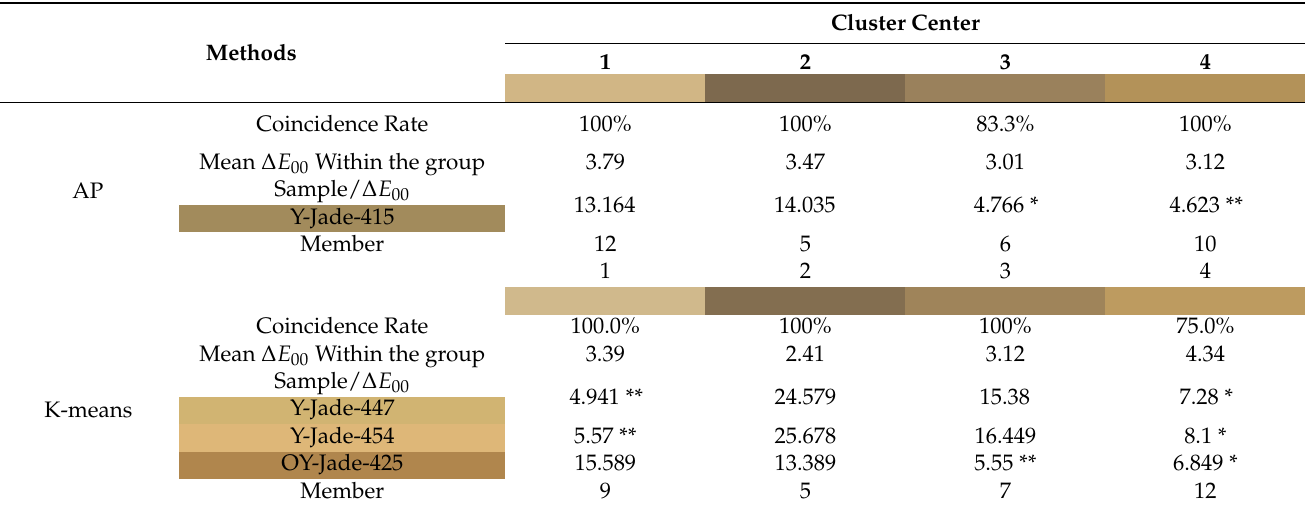
Figure 7. The three-dimensional casting diagram (Lightness L ∗ , Colorimetric Coordinate a ∗ b ∗ ) of yellow jadeite based on the CIE1976 L ∗ a ∗ b ∗ uniform color space by AP and K-means cluster methods. Table 1. The cluster results of AP and